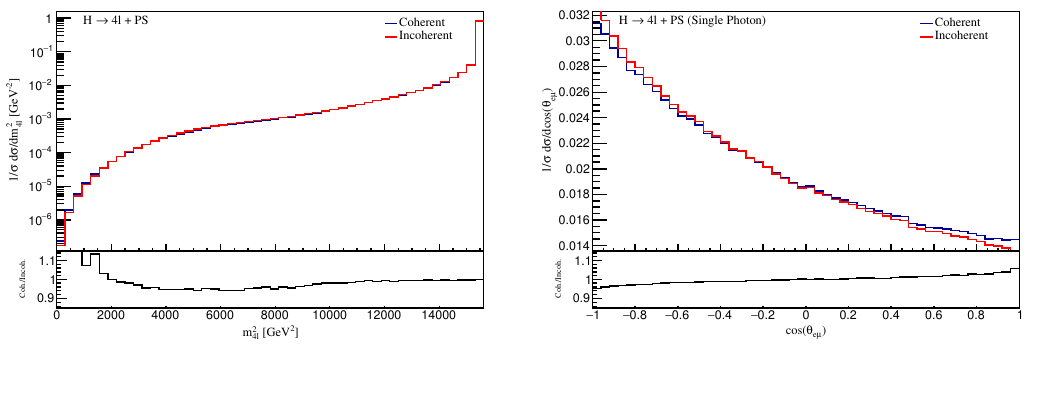
Figure 10 . Invariant mass distribution of the leptons (left) and the angle between the e (cid:0) and the (cid:22) (cid:0) for single photon events (right) after application of the incoherent shower and the coherent sector approach for a Higgs mass of 125 GeV. The parameters (cid:11) and t Pythia